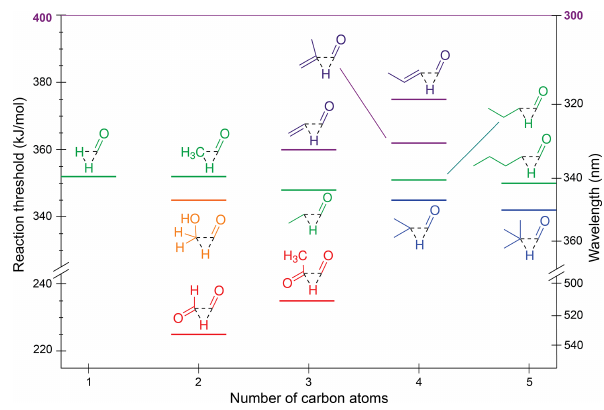
Figure 4. Zero-point vibrational-energy-corrected B2GP-PLYP- D3/def2-TZVP S 0 decarbonylation